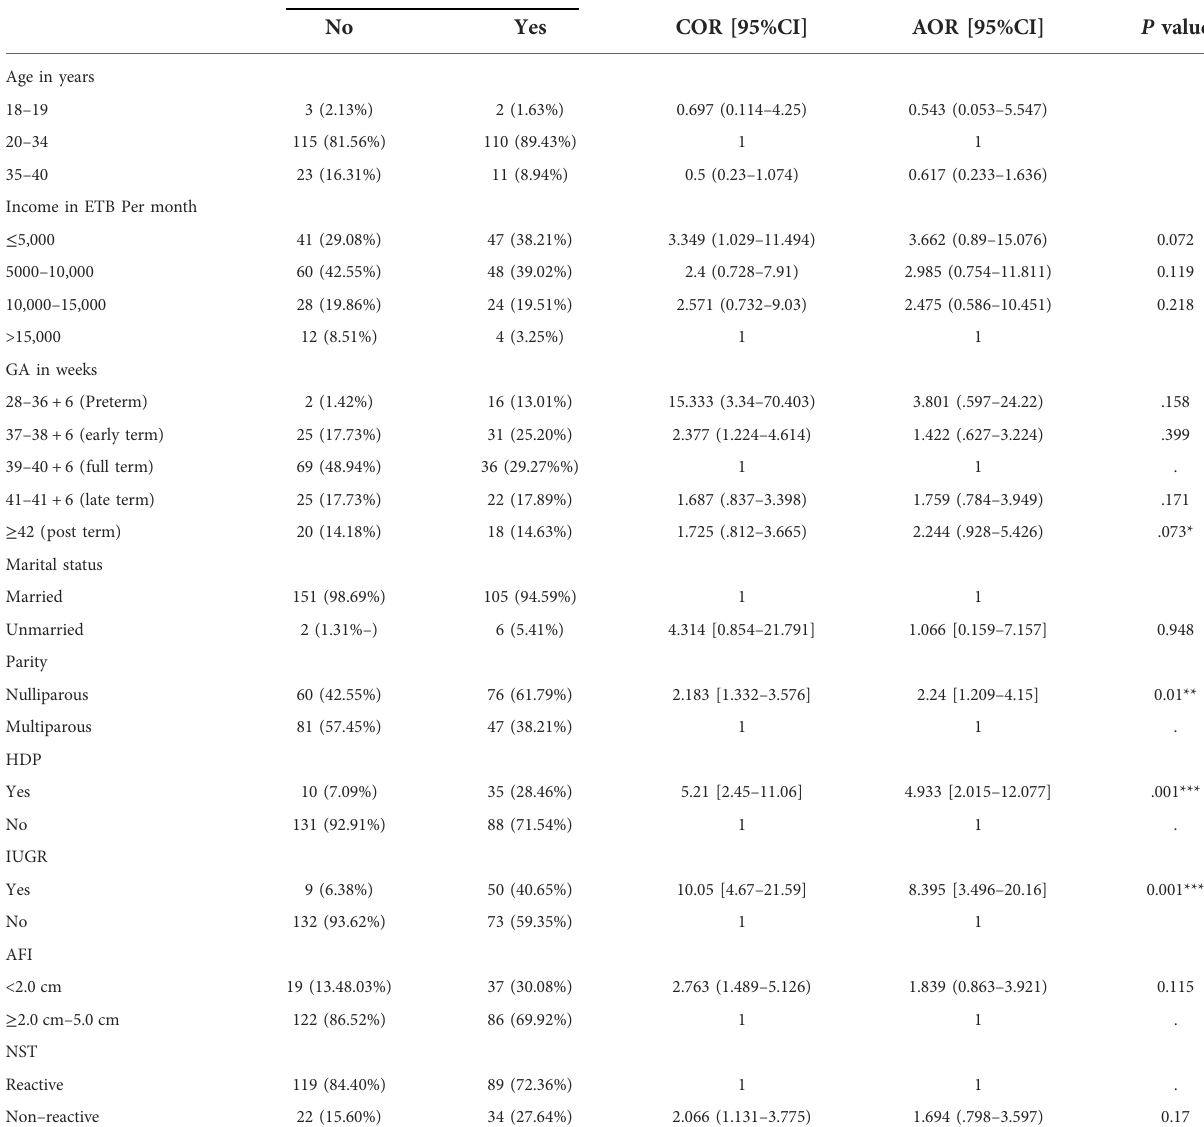
TABLE 7 Bivariate and multivariable analysis of factors associated with adverse perinatal outcome, 2021.